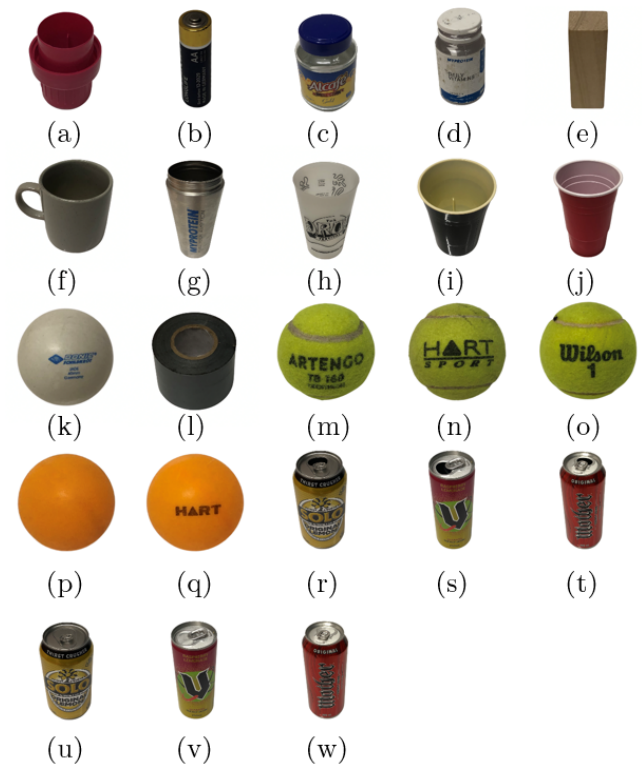
Figure 1. The 23 household objects characterised in this paper: ( a ) bottle cap, ( b ) AA battery, ( c ) empty jar, ( d ) empty container, ( e ) small wooden block, ( f ) porcelain mug, ( g ) metal cup, ( h )